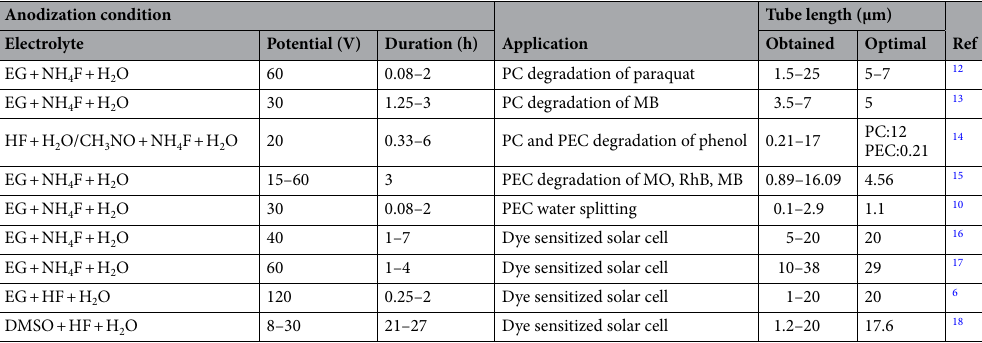
Table 1. Reported optimum tube lengths of TNTAs for organic pollutant decomposition, photovoltaics, and water splitting. EG ethylene glycol, PC photocatalytic, MB methylene blue, MO methyl orange, RhB rhodamine B.